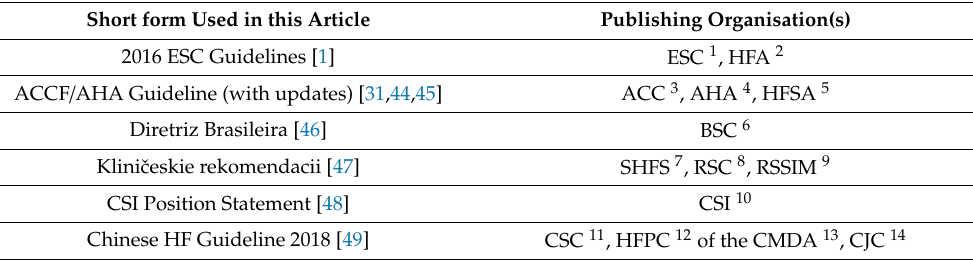
Table 1. Clinical practice guidelines included in the